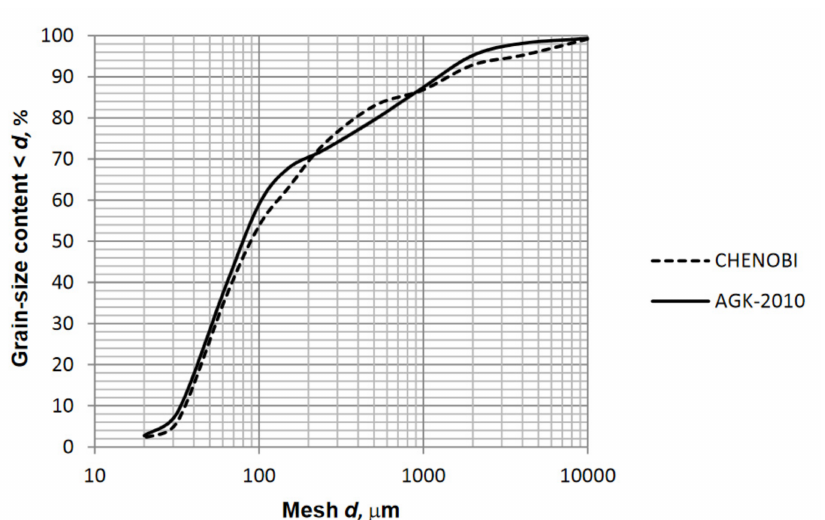
Figure 3. Particle size distribution (PSD) of the lunar regolith simulants—American “Chenobi” of uniformity coefficient, Cu = 3.68 (dashed line) and Polish “AGK-2010” of uniformity coefficient, Cu = 3.54 (solid line). Reprinted from